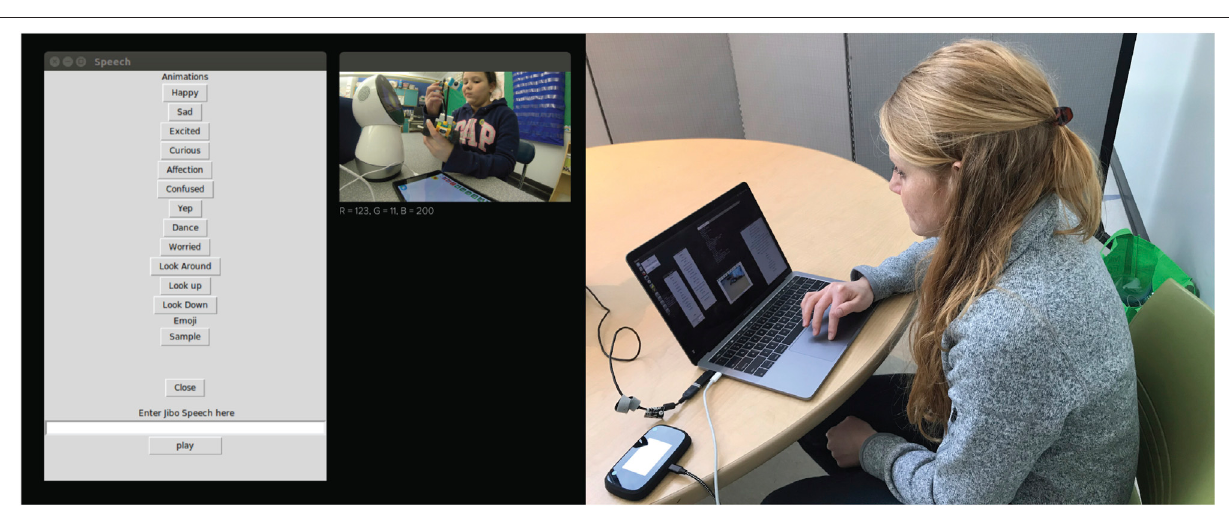
Frontiers in Robotics and AI |